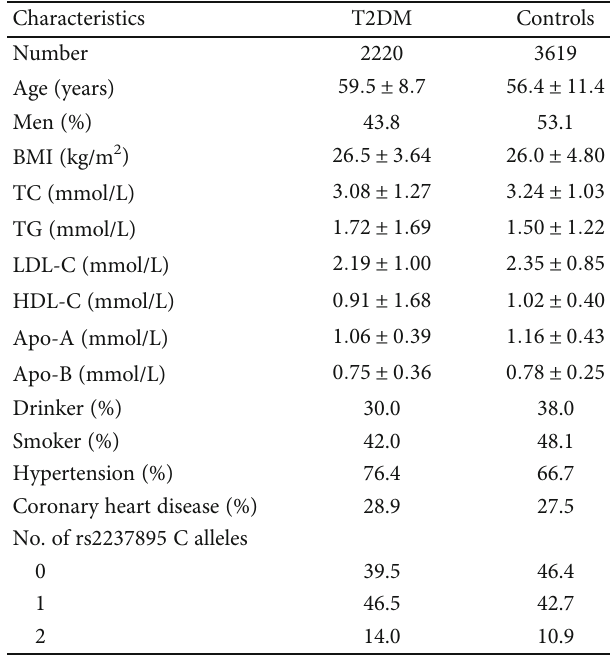
Table 1: Baseline characteristics of individuals with type 2 diabetes (T2DM) and control subjects.